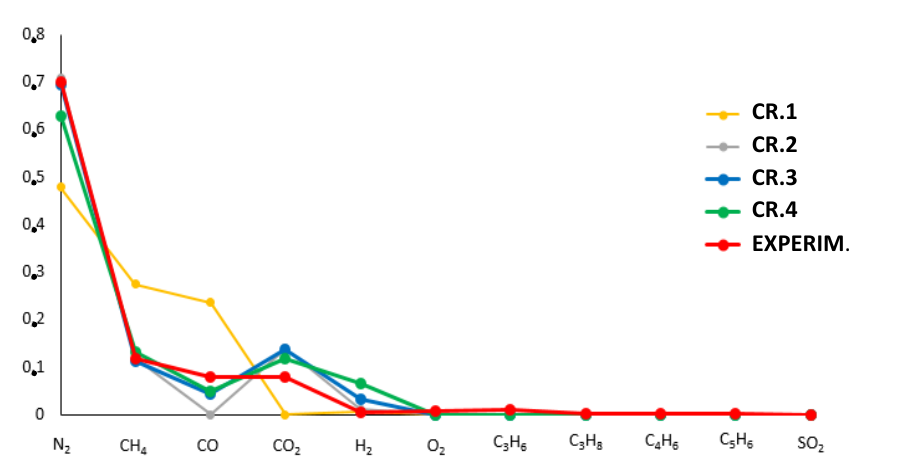
Figure 8. Comparison between calculated and measured syngas composition.